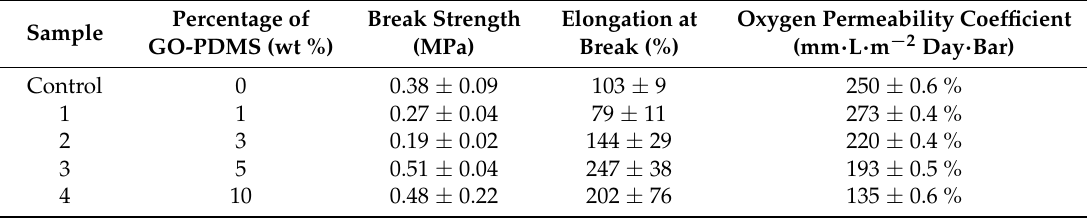
Table 4. Mechanical properties and oxygen permeability of graphene oxide (GO)-reinforced silicones (Summarized from Reference